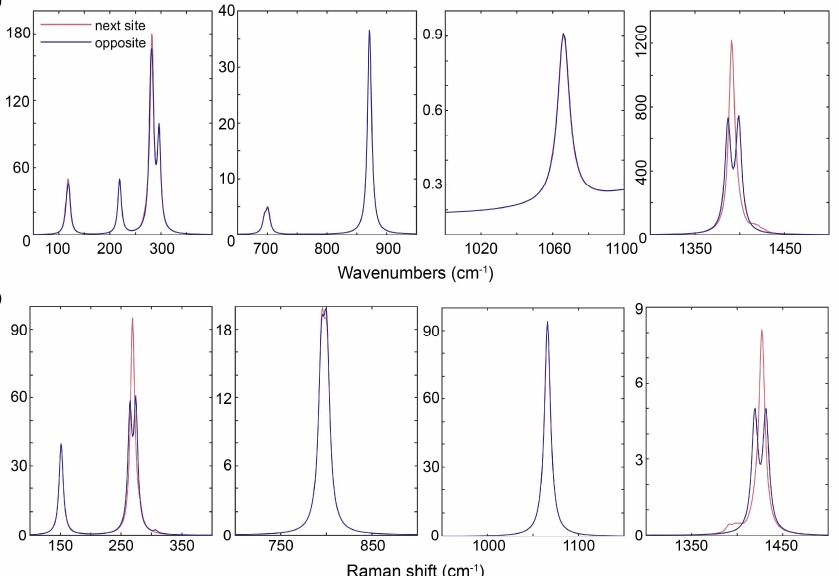
Figure 4. Calculated band shifts, new band formation, and intensity changes associated with the distribution of 18 O in C 16 O 2 18 O in calcite: ( a ) infrared spectra and ( b ) Raman spectra. The regions outside of the plotted areas have no vibrational bands visible. Note that the individual spectral regions of interest are plotted with different y axes to facilitate visualization.